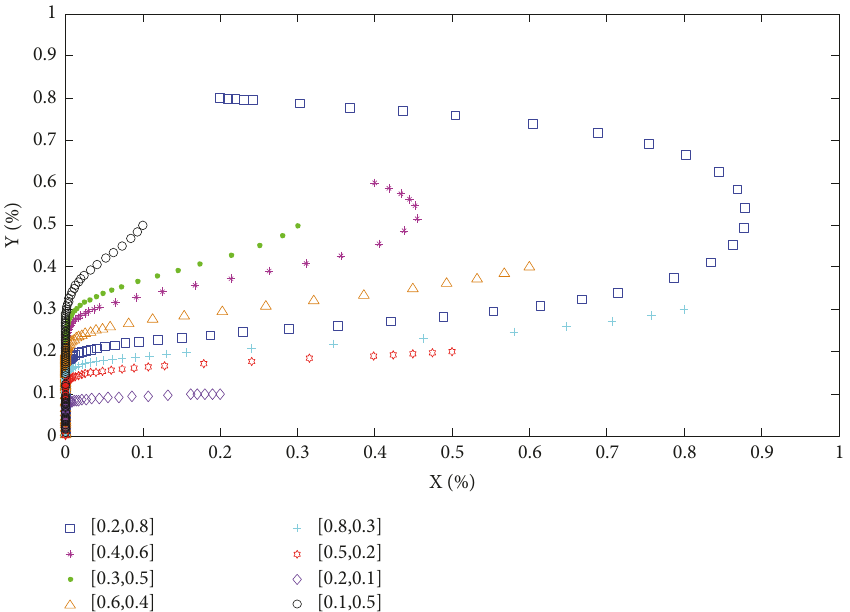
Figure 7: The Y-X type of phase diagram (ESS: A(0,0)).